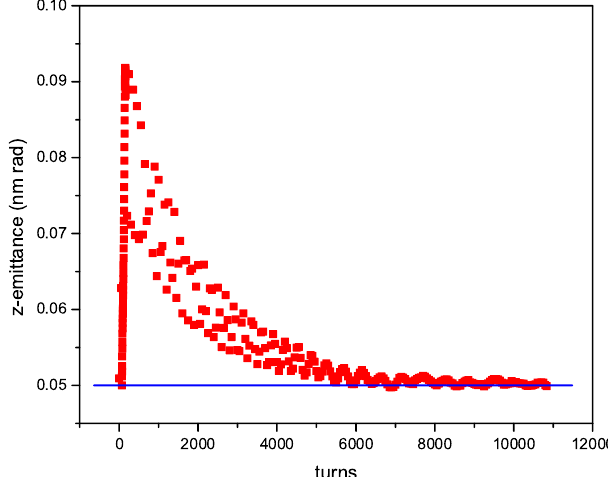
FIG. 7. (Color) Simulated vertical emittance variation with turn